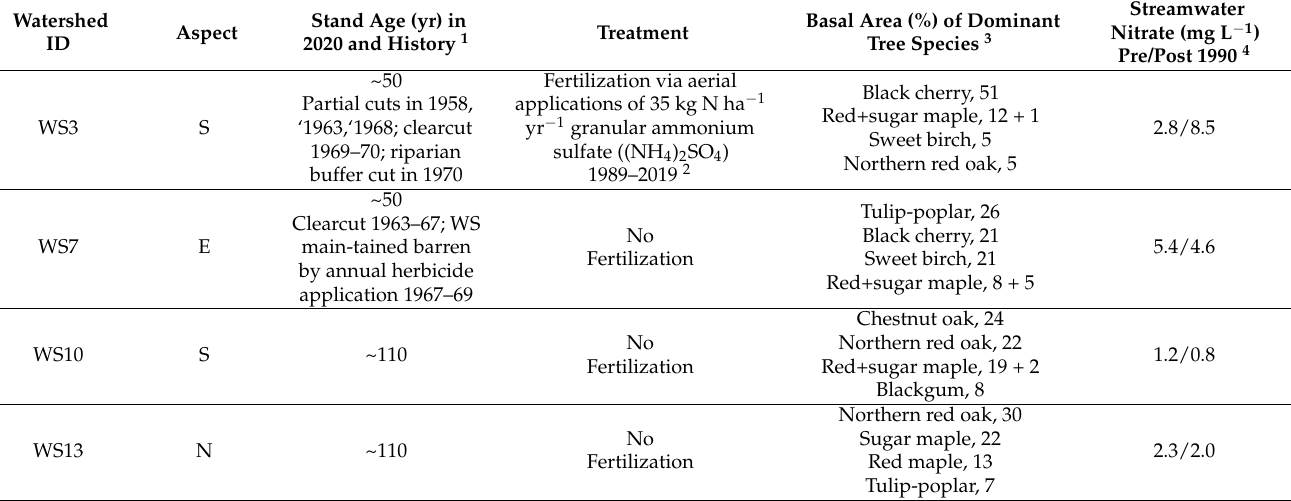
Table 1. Characteristics of the mixed-hardwoods watersheds (WS) from which tree and herb-layer tissue were collected for analysis of nitrate reductase activity. The watersheds are located in the Fernow Experimental Forest, Parsons, WV,